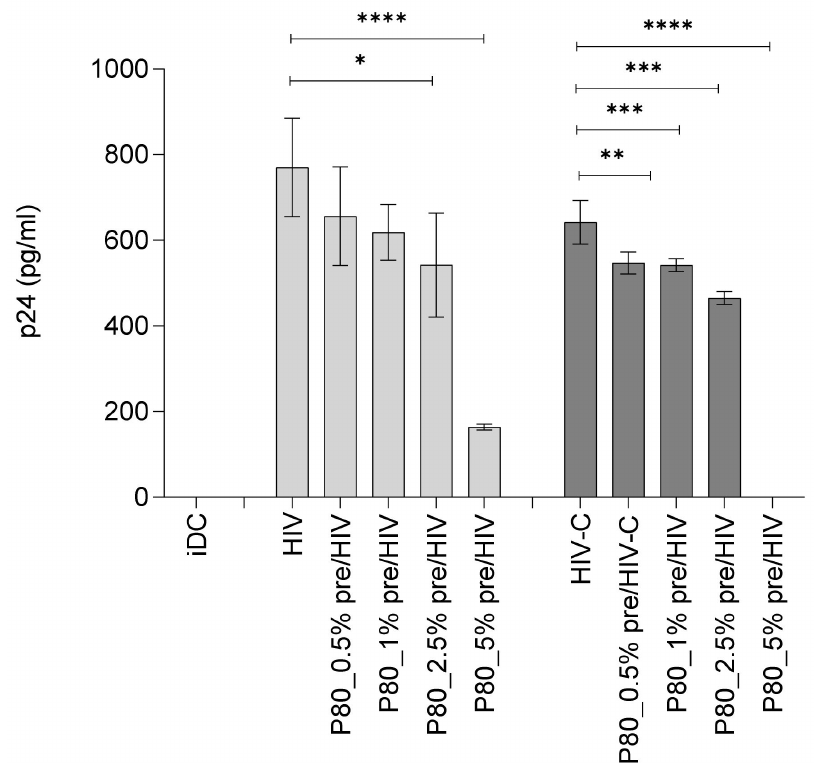
Figure 2. The binding of HIV and HIV-C to DCs is differentially affected by the P80 natural essence. HIV-1 binding to DCs was not significantly changed by pre-incubation of cells using 0.5% and 1% P80 natural essence, while HIV-C binding was significantly decreased in these concentrations. At P80 concentrations above 2.5%, a highly significant reduction in HIV and HIV-C binding to DCs was detected (HIV, light grey bars; HIV-C, dark grey bars). Uninfected iDCs were used as negative controls. Data were obtained in three independent experiments and a summary of all experiments is illustrated. Statistical analyses were done using GraphPad Prism software and one-way ANOVA with Dunnett’s post-test. * p < 0.05, ** p <0.01, *** p < 0.001, **** p <